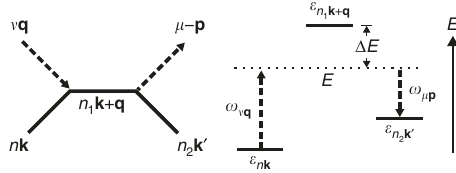
Fig. 3 Energetics of two-phonon processes. The example 1e1a process discussed in the text, with its energetics shown on the right.